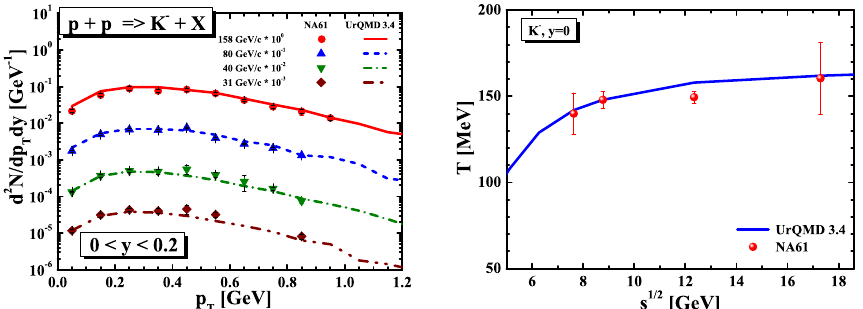
Figure 3. (Left:) the UrQMD v3.4 results (lines) for the transverse momentum spectra of K − produced at 0 < y < 0.2 in inelastic p + p interactions at 31, 40, 80 and 158 GeV / c in comparison to experimental data from the NA61 / SHINE Collaboration (symbols) [1]. (Right:) the UrQMD v3.4 simulations for the inverse slope parameter of K − at y ≈ 0, in comparison to experimental data from the NA61 / SHINE Collaboration (symbols). The NA61 data points have been read o ff from Fig. 33 in Ref.